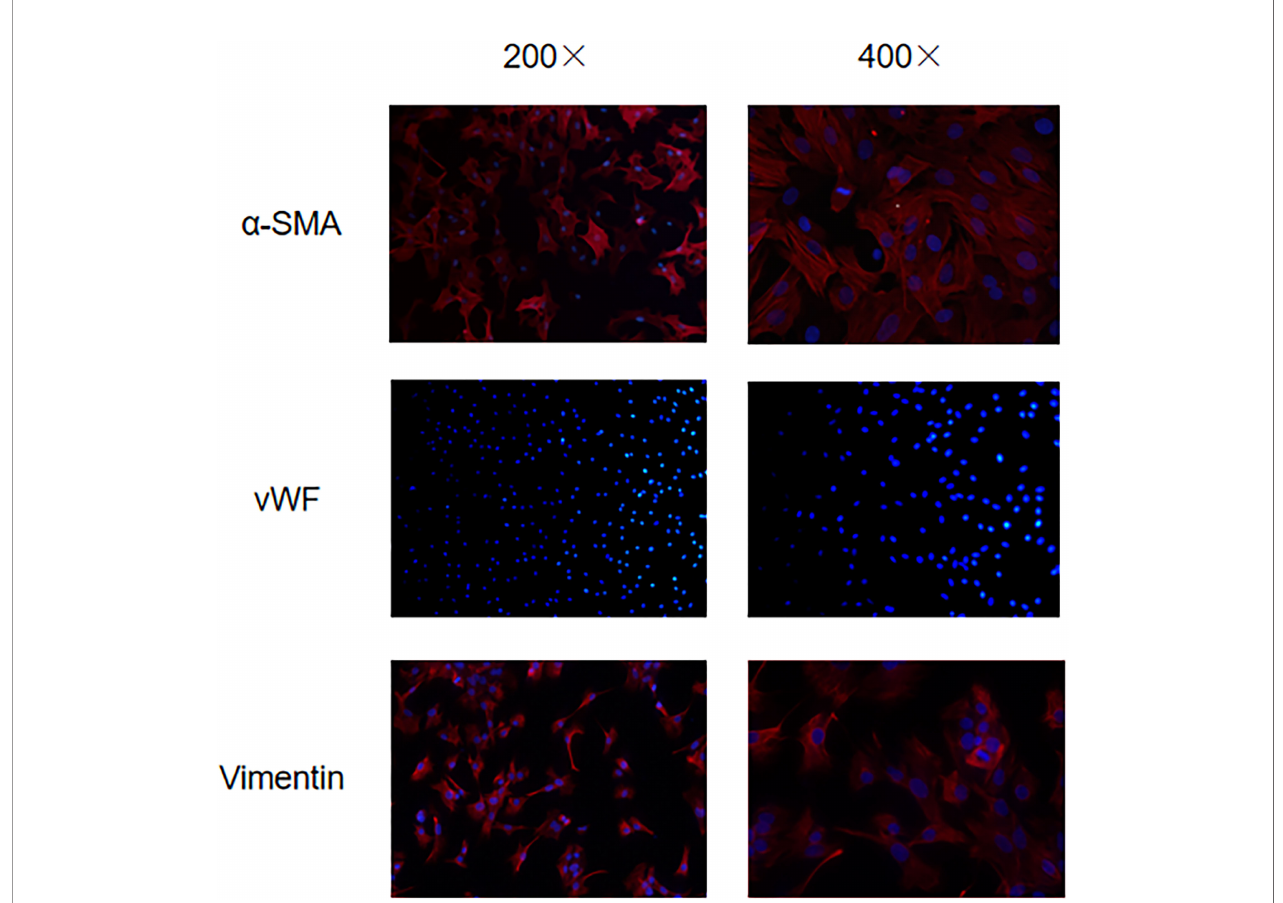
FIGURE 1 | Immuno fl uorescence microscopy to identify the expression of a -SMA/vWF/Vimentin in